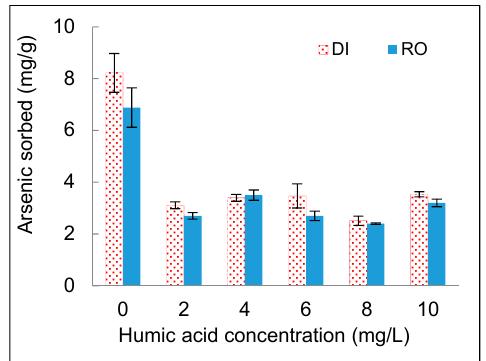
Figure 6. Effect of humic acid on arsenic sorption onto the DWTS at sorbent dosage of 1 g/L, initial arsenic concentration of 20 mg/L, pH 7 and 23 °C. The error bars represent the standard deviation of duplicate testing results.